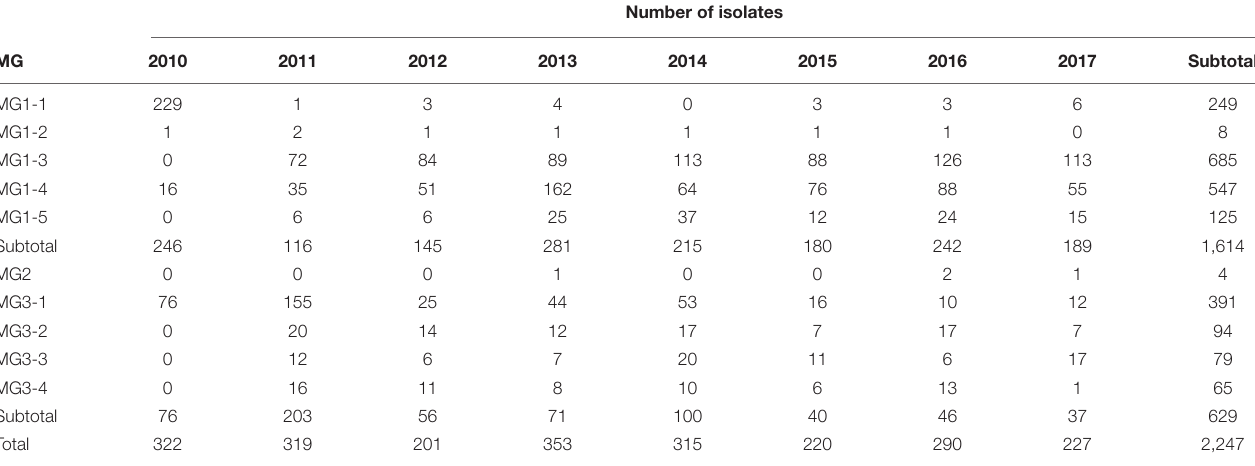
TABLE 8 | Numbers of Puccinia striiformis f. sp. tritici isolates in the molecular groups (MGs) identified by hierarchical cluster analysis among 8 years from 2020 to 2017. Number of